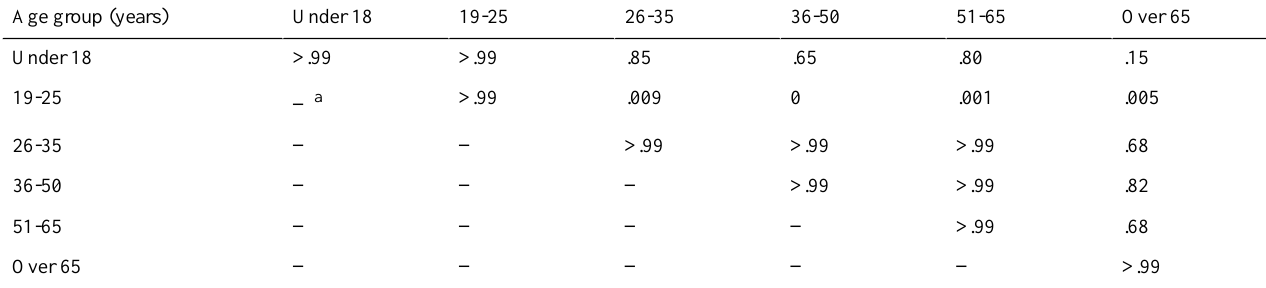
Table 5. Post hoc comparisons ( P values) among Kmean values of age subgroups using Hochberg GT2